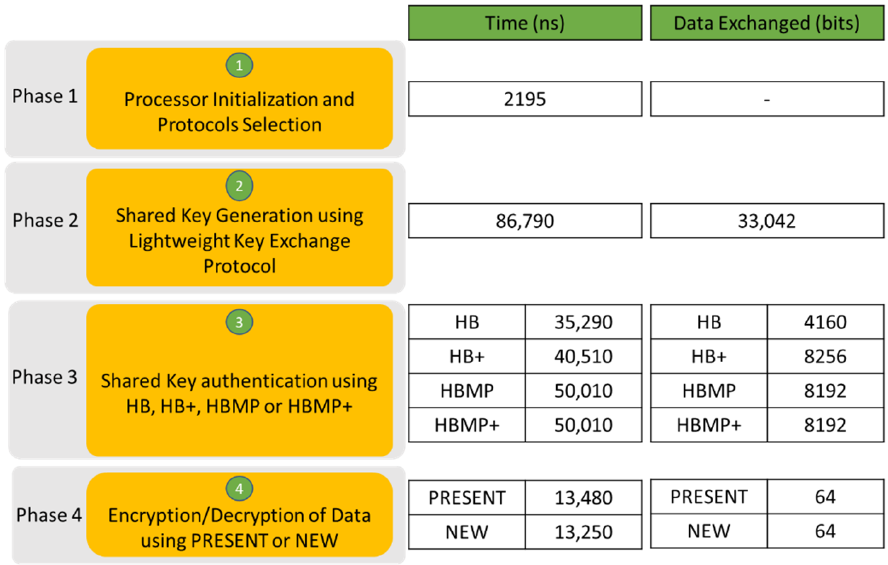
Figure 19. Simulation results.